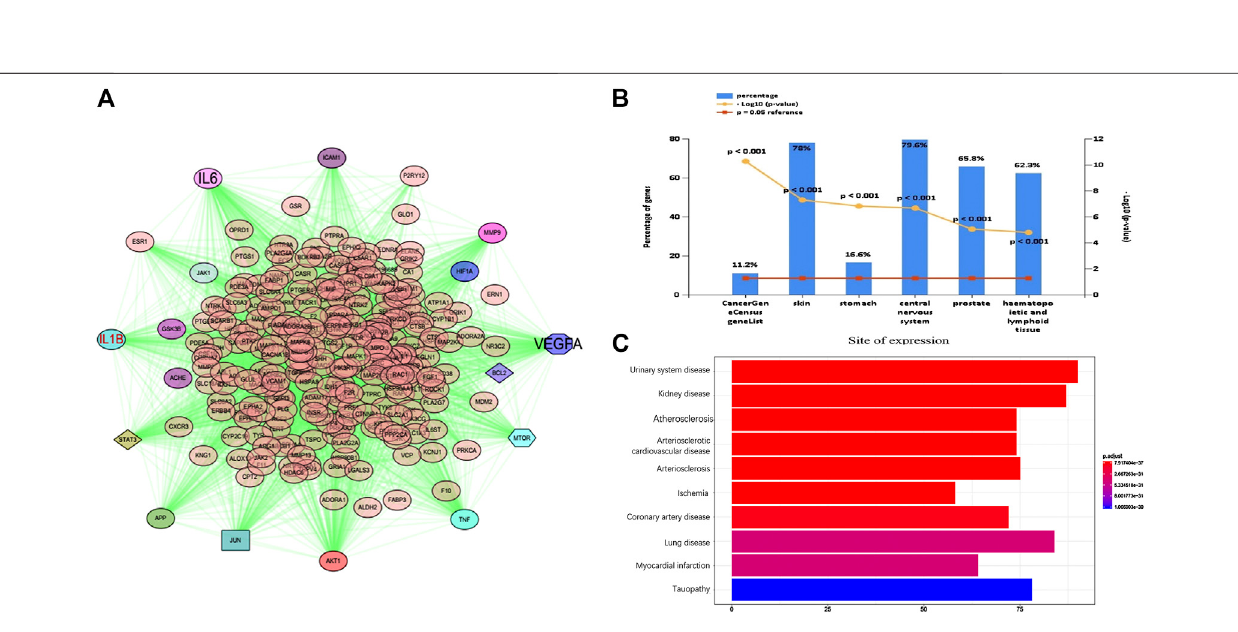
Frontiers in Pharmacology |